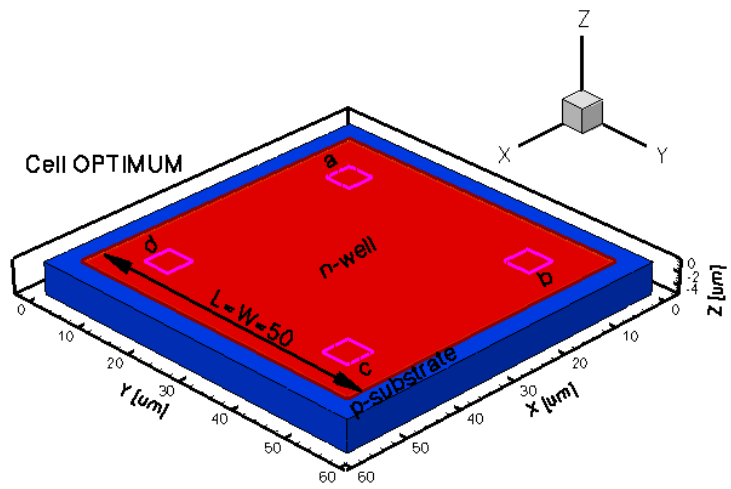
Figure 6. 3D representation of the optimum simulated Hall